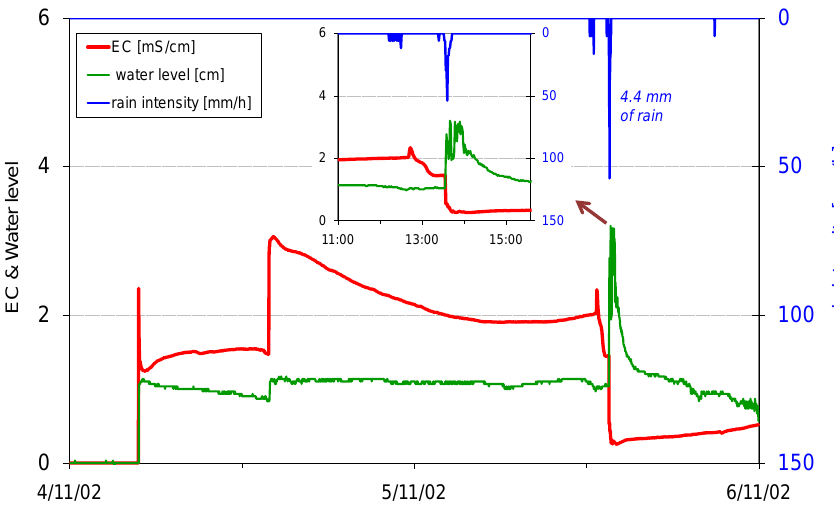
Fig. 10. Measured runoff quantity and electrical conductivity (EC) at Station M, Modiin at the beginning of the rainy season.